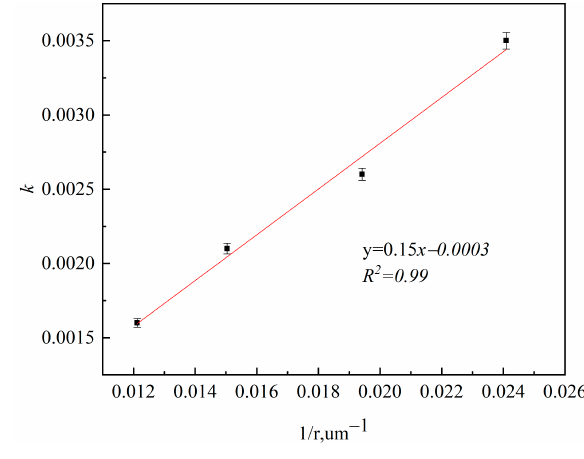
Figure 14. Plot of k and 1/ r .